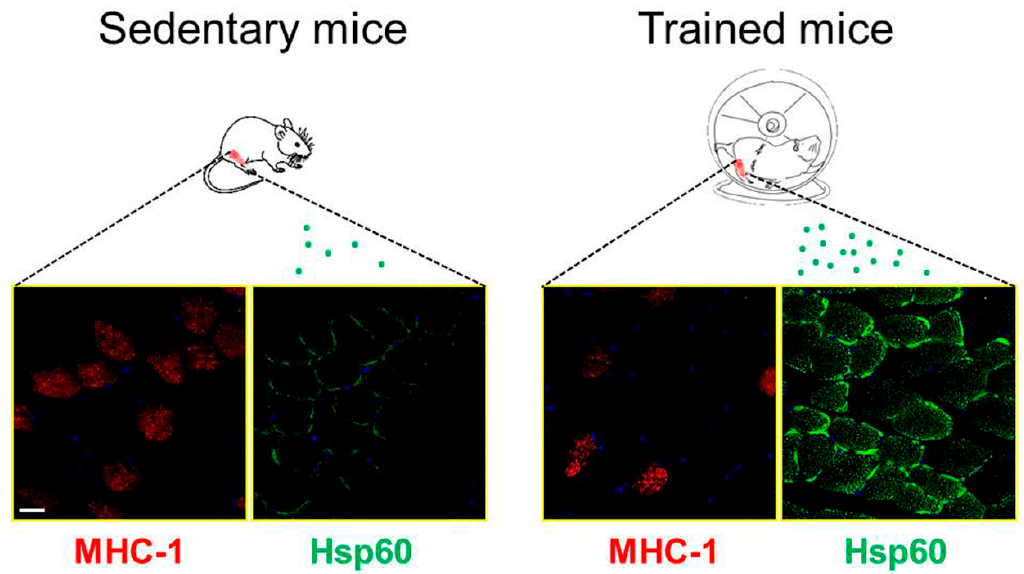
Figure 2. Hsp60 protein levels increase in trained mice, and they show the localization of Hsp60 in the myofibrillar cell. Immunofluorescence for Hsp60 and MHC-I (Myosin Heavy Chain–I) of cross-sections of sedentary and trained mice at 45 days in red gastrocnemius muscle. The figures show the increase of Hsp60 immunoreactivity in particular in type I muscle fibers. These fibers are particularly involved in muscle adaptation after endurance protocol training. Bar 25 μ m.